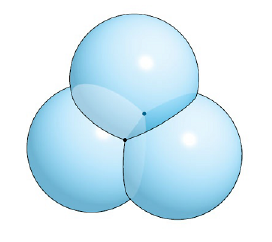
bifurcation point (or turning point) from which start m +1 different branches of weak solutions: on one hand, the branch of “ classical” ground states u , forming a branch of stable equilibria, and, on the other hand, m λ branches formed by unstable compactly supported weak solutions, of the form w σ ( x : x ) = σ − 2 1− · u (( x − α 0, j λ * λ 2( β − α ) x 0, j )/ σ ) with λ = σ − 1− α (see Figure 1) and m different points x 0, j , j = 1, ..., m . Furthermore, we know a global information: the energy of u is the maximum among all the possible energies associated to any weak λ * solution of P ( α , β , λ ) (due to the monotone dependence of E with respect to λ ) and for λ > λ * there are several λ ground states u = w σ with compact support and with an energy less than the one of u . λ λ * λ